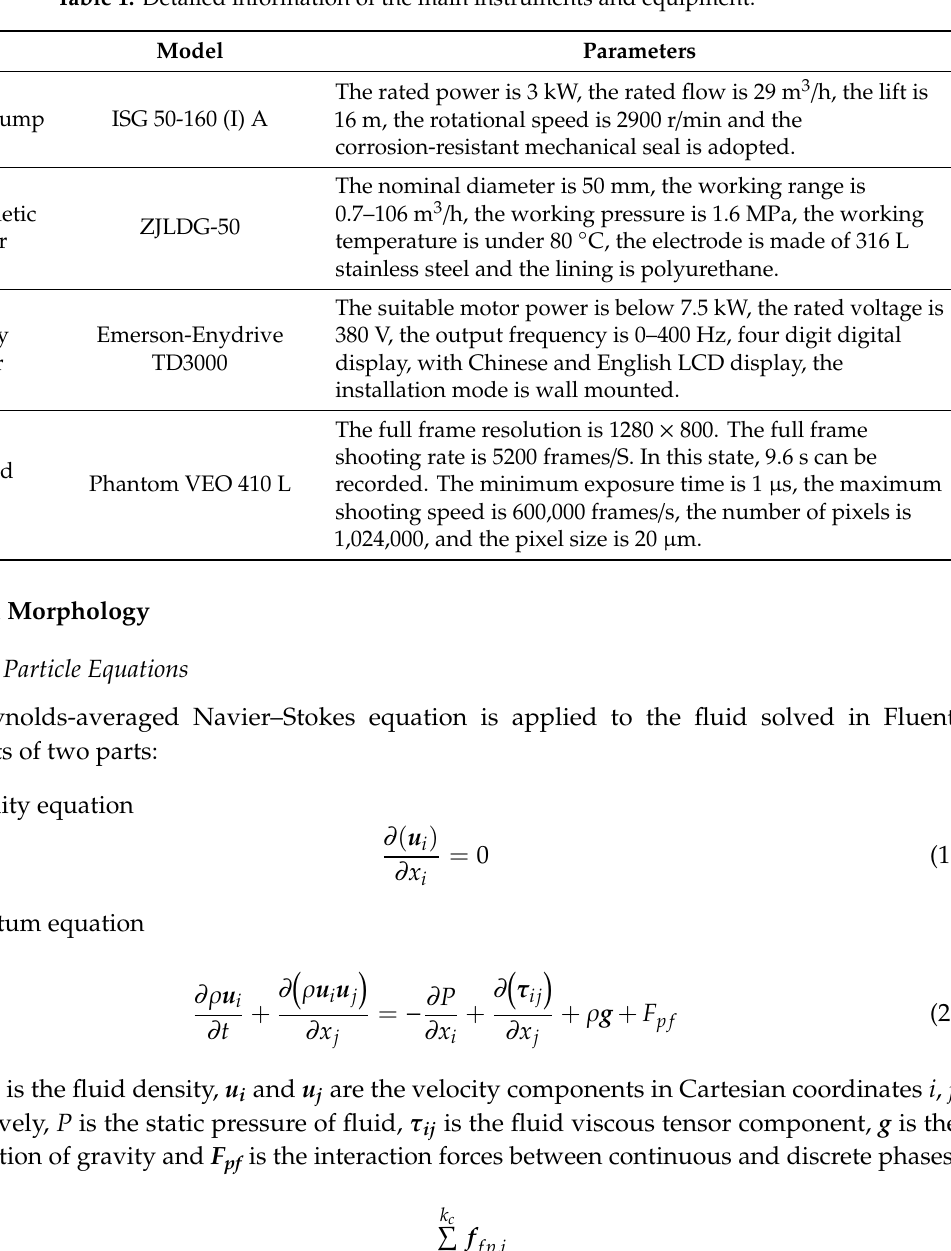
Table 1. Detailed information of the main instruments and